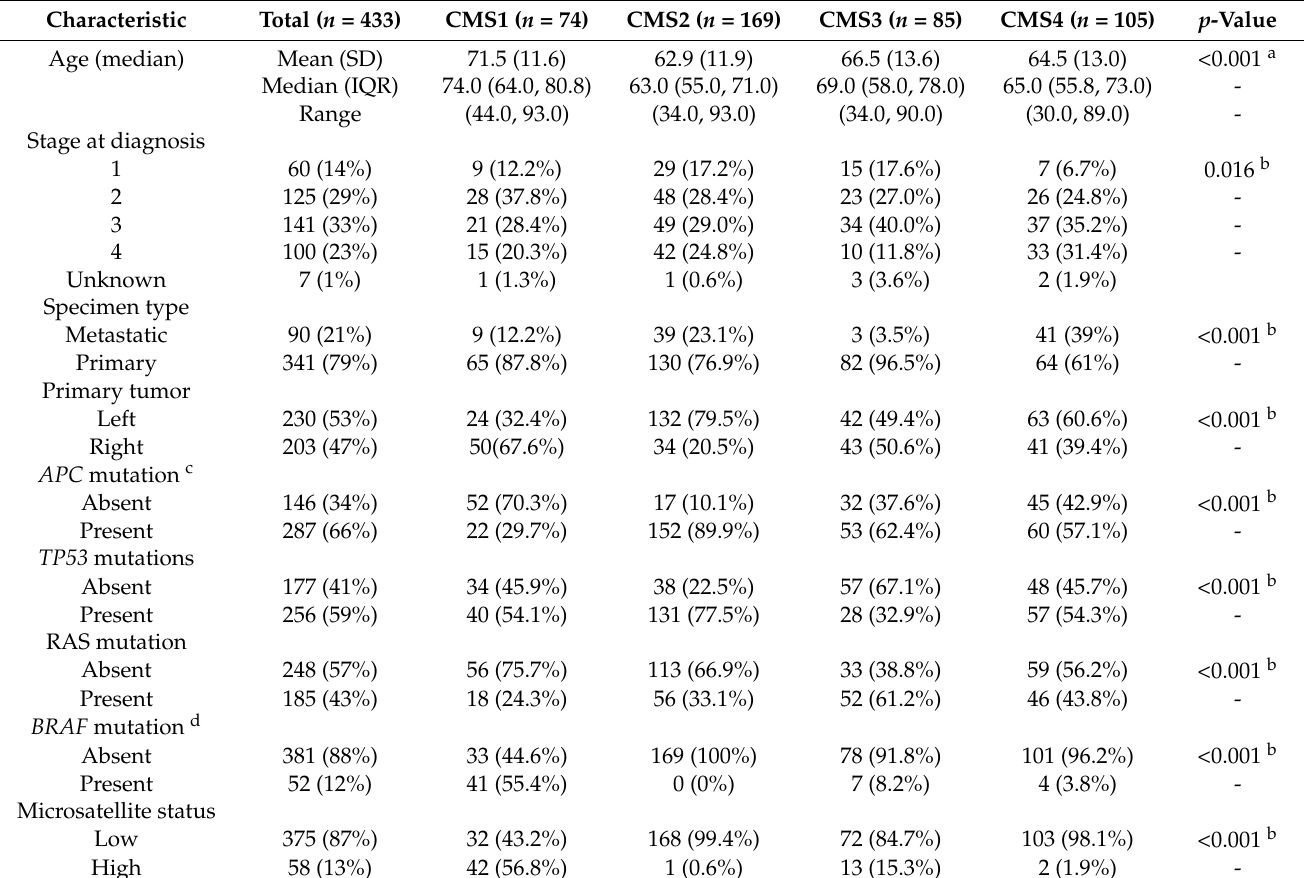
Table 1. Baseline characteristics of Moffitt 468 CRC